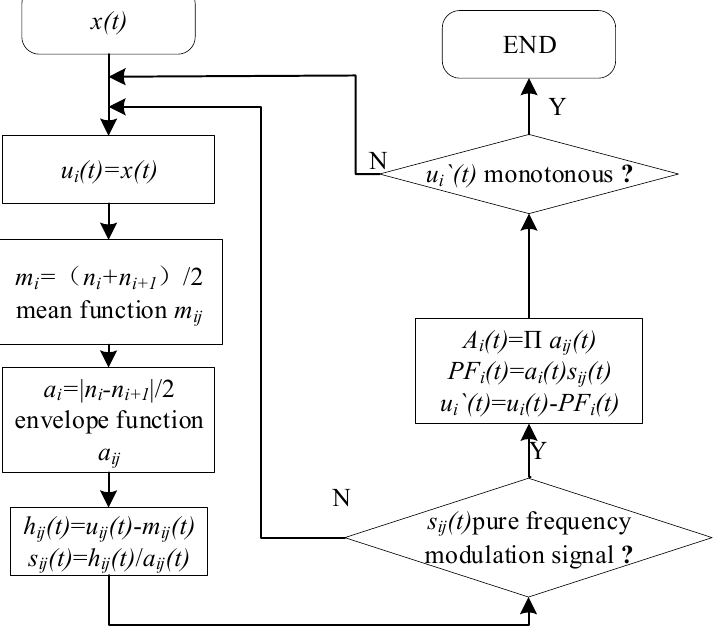
Figure 3. Local mean decomposition.